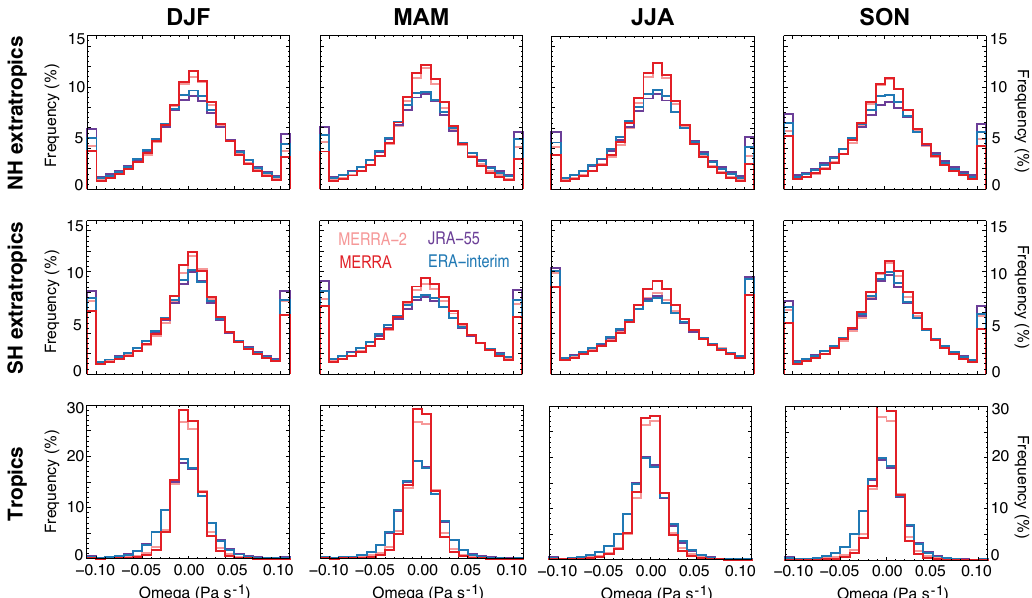
Figure 16. Probability density functions (PDFs) of vertical wind (omega; Pas − 1 ) at the tropopause in the (top row) NH extratropics, (middle row) SH extratropics, and (bottom row) tropics for each season (columns from left to right are DJF, MAM, JJA, and SON, respectively). JRA-55 is shown by the purple lines, ERA-Interim by the blue lines, MERRA-2 by the light red lines, and MERRA by the dark red lines. Note that the vertical wind extremes (i.e., those beyond the limits of the abscissa) are consolidated into the leftmost and rightmost bins of each PDF.